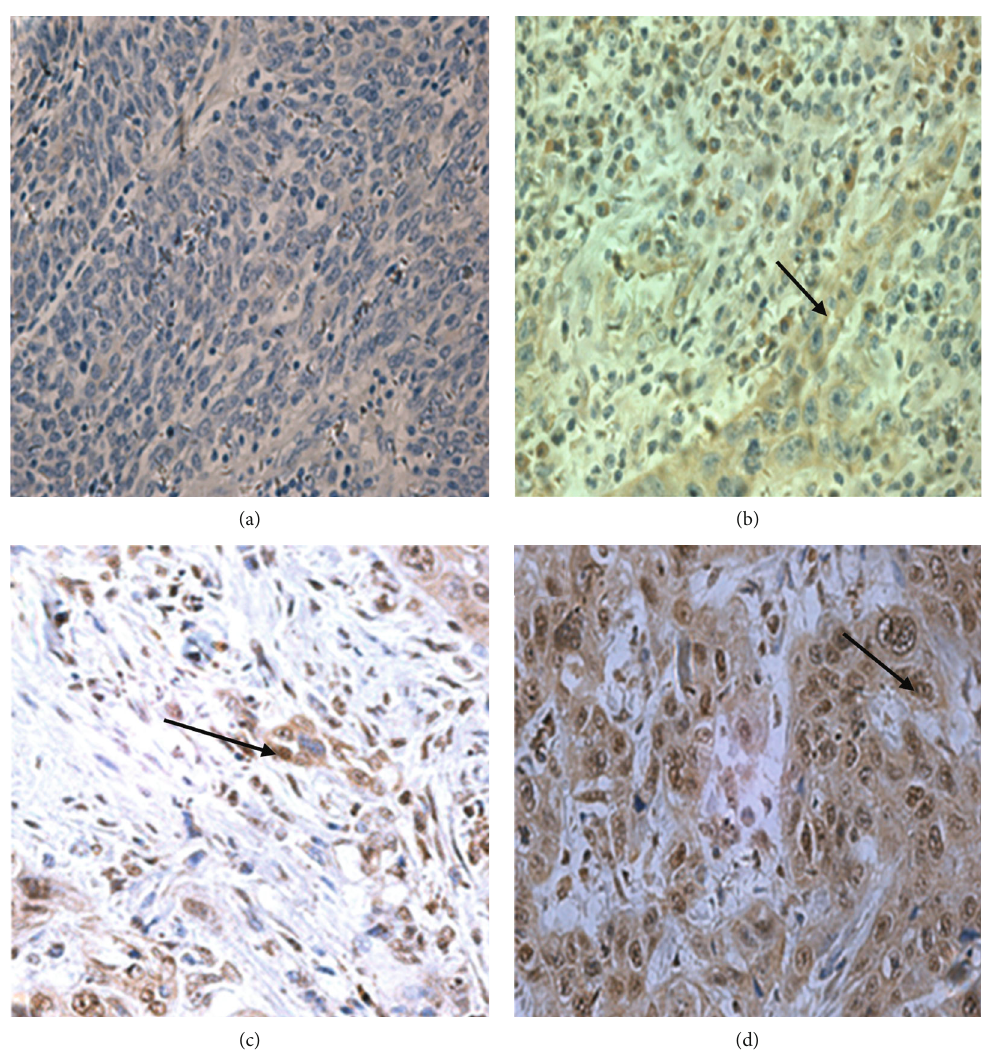
Figure 4: Immunohistochemistry expressions of EGFR in tumor tissues. (a) Negative EGFR (0). (b) Weak levels of EGFR (1+). (c) Moderate levels of EGFR (2+). (d) High levels of EGFR (3+). The data were produced from 3-5 fi elds per slide. Magni fi cation × 400. Table 3: Diagnostic performance of gene expressions in predicting head and neck malignant tumors. Gene Cut-o